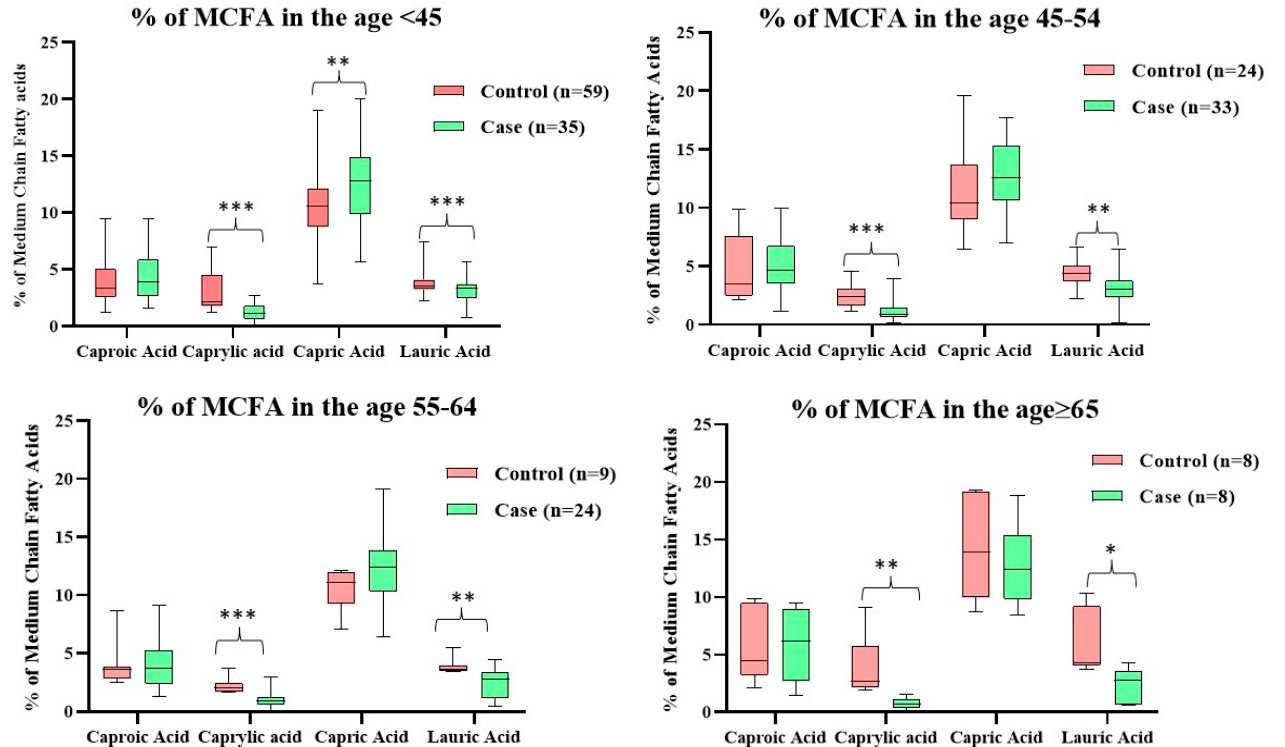
Figure 1. Age-wise distribution of MCFA levels in control and breast cancer subjects. The amount of each MCFA was calculated as a % of total MCFAs. p -value was calculated using Mann–Whitney U test for non-parametric variables. Data are shown as median (interquartile range). *** p < 0.0001, ** p < 0.001, and * p < 0.05. Abbreviations: MCFA—Medium-chain fatty